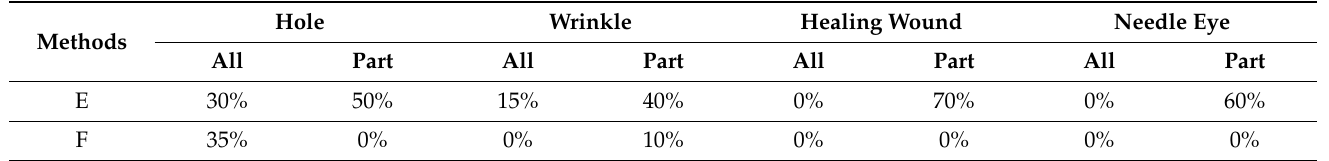
Table 2. The detected result by using edge detector.